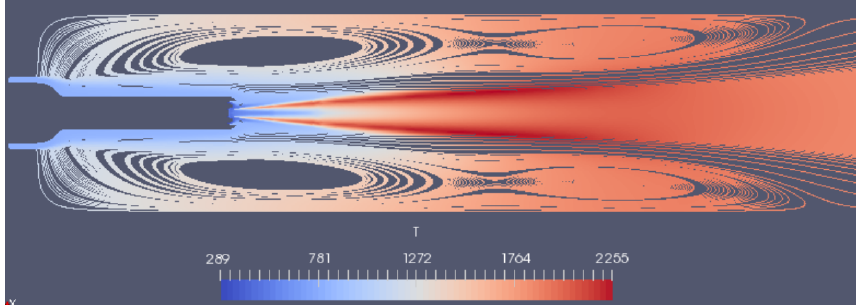
Figure 9. Streamline and temperature contour plot on the vertical longitudinal cross-section with the 2D simulation. For improved visibility, the upper half is